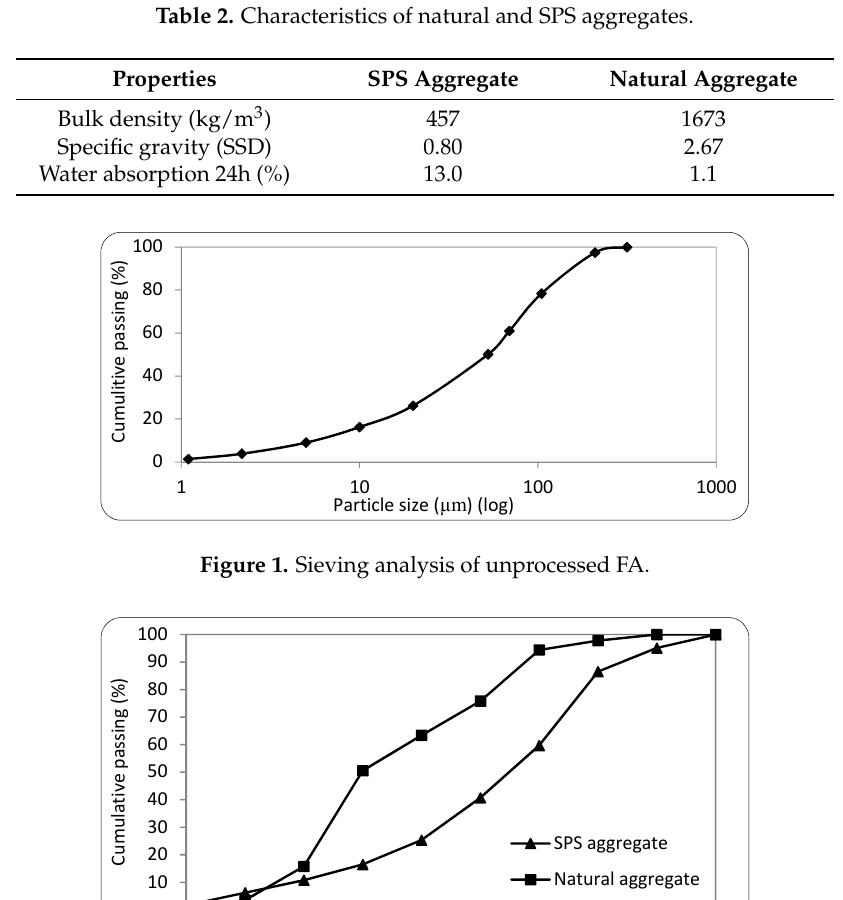
Figure 2. Sieving analysis of natural and SPS aggregates.